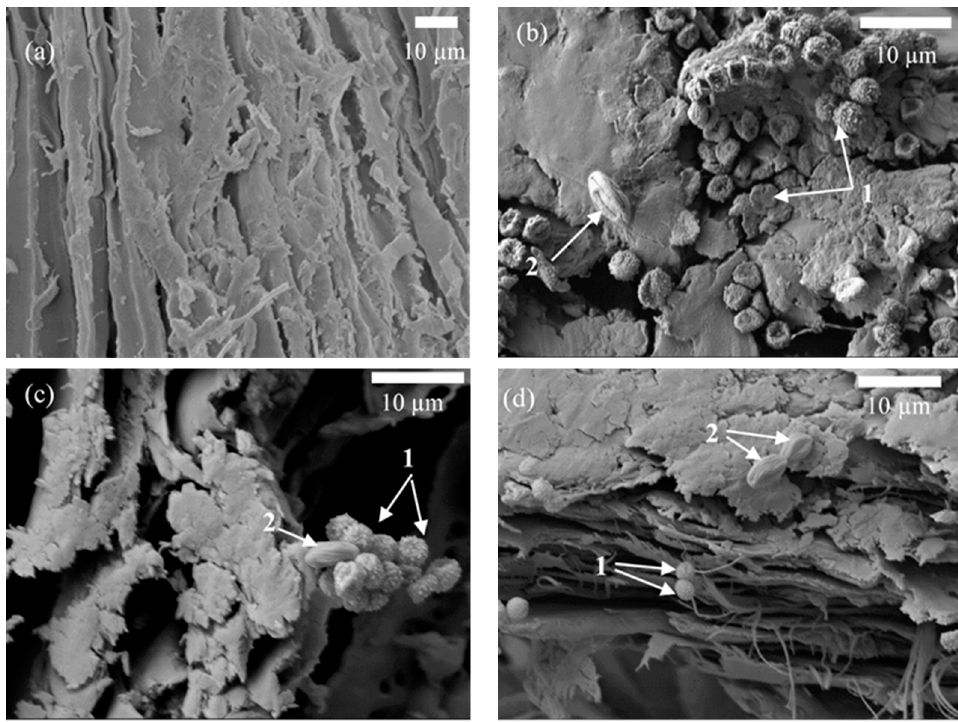
Figure 6. Microstructure of BcB with G composition as determined by SEM: ( a ) before incubation (magnification ×1000); ( b ) 6 months after incubation—1 mm depth of BcB (1— A. fumigatus , 2— Rh. oryzae ) (magnification ×3000); ( c ) 6 months after incubation—2–2.5 mm depth of the BcB (1— A. fumigatus , 2— Rh. oryzae ) (magnification ×3000); ( d ) 6 months after incubation—the middle of the BcB (1— A. fumigatus , 2— Rh. oryzae ) (magnification ×2000).